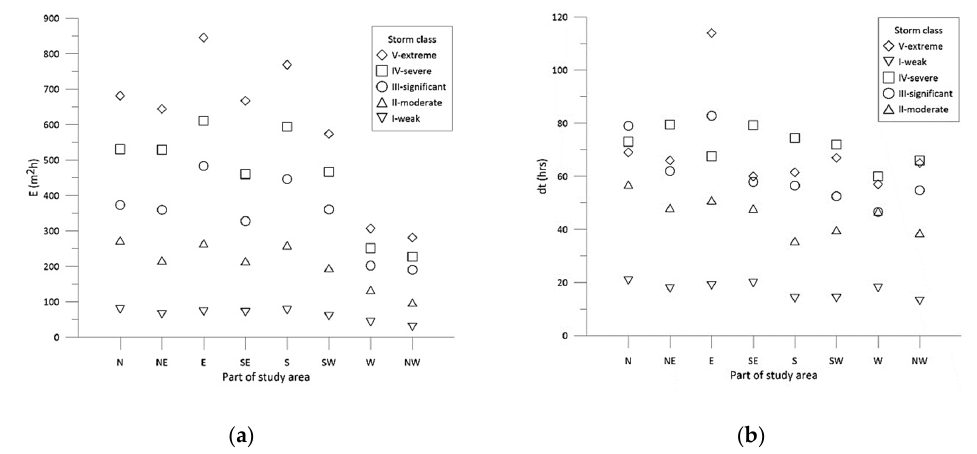
Figure 6. Average ( a ) wave energy and ( b ) duration for each storm class per geographical section of study area.